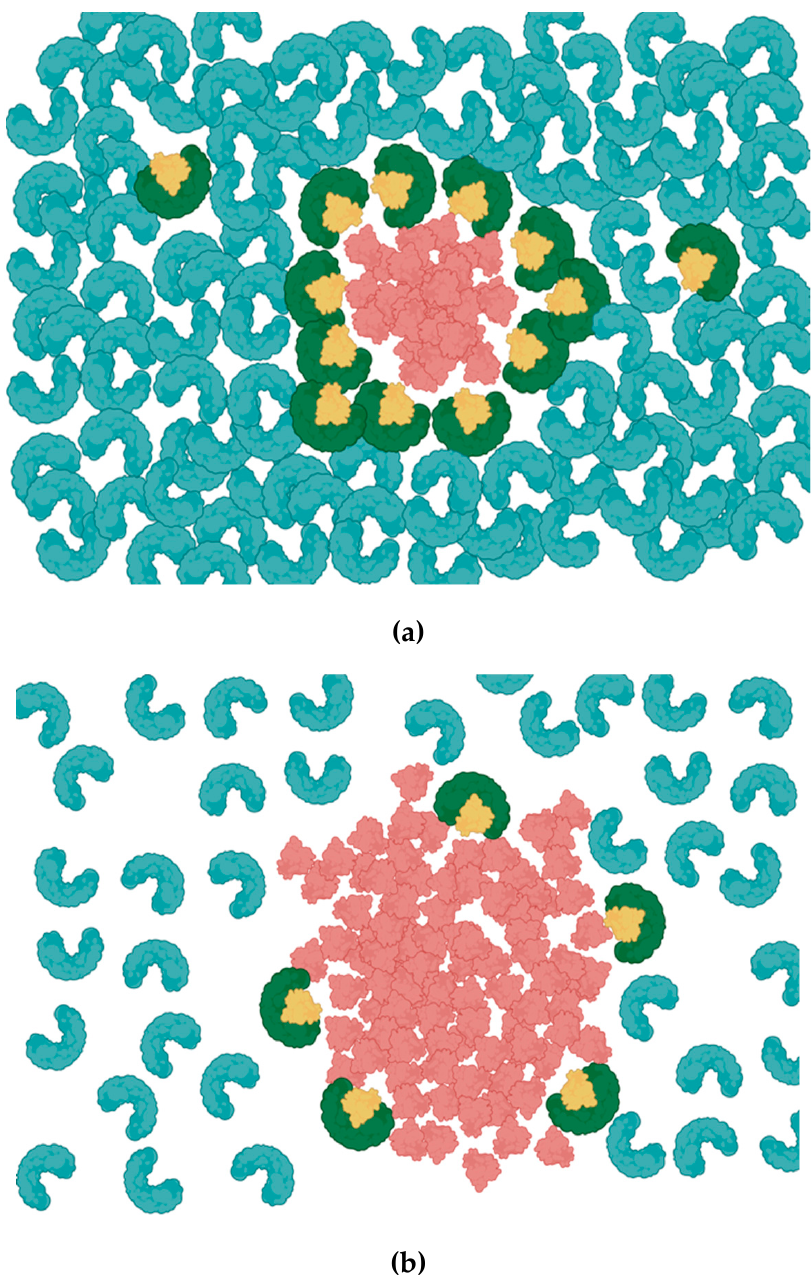
Figure 1. Alpha-1 Antitrypsin (AAT) inhibition of neutrophils elastase (NE). ( a ) AAT (Blue) is abundant and uniformly distributed in circulation. AAT constrains the activity of NE (red) by forming a 1:1 AAT/NE complex (AAT; green, NE; yellow). ( b ) Relatively low concentration of AAT due to inherited AAT deficiency leaves large proportion of NE unopposed, allowing NE to spread into a larger area.